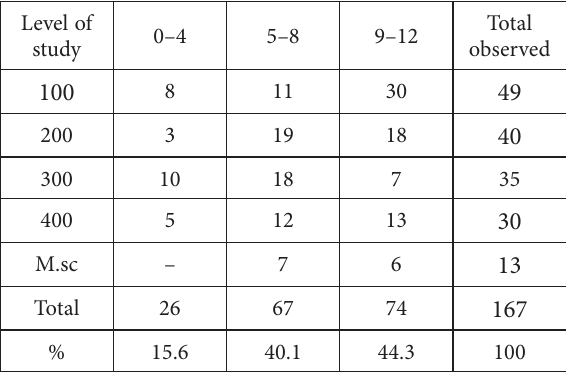
Table 6. Distribution of score of statistical diagram test